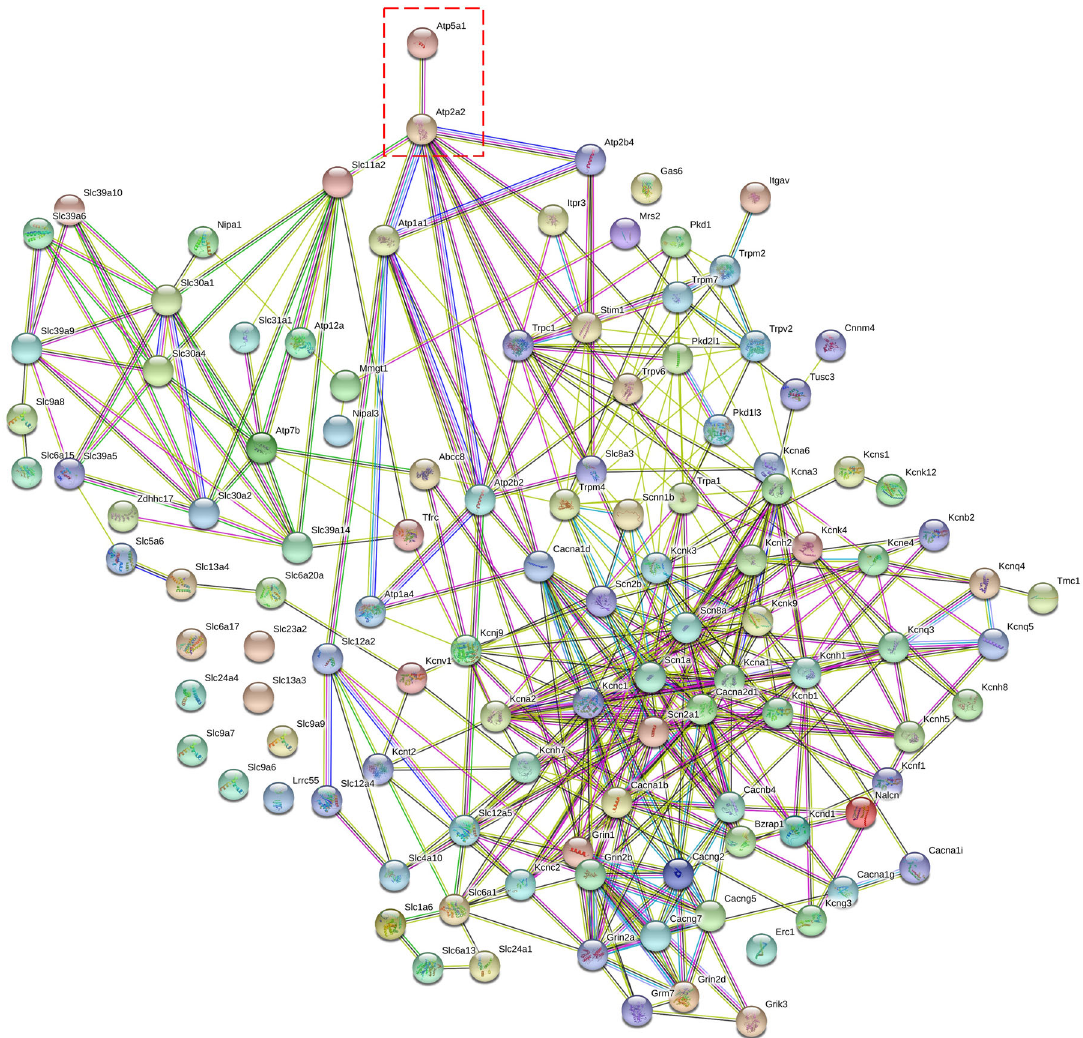
Fig. 2 Network analysis based on the gene list. Metal ion trans-membrane transporter activity. Atp5a1 was added to the gene list as it is the known target of J147. Atp5a1 interacts with Atp2a2 (red box), implying a possible functional link between both genes based on murine co-